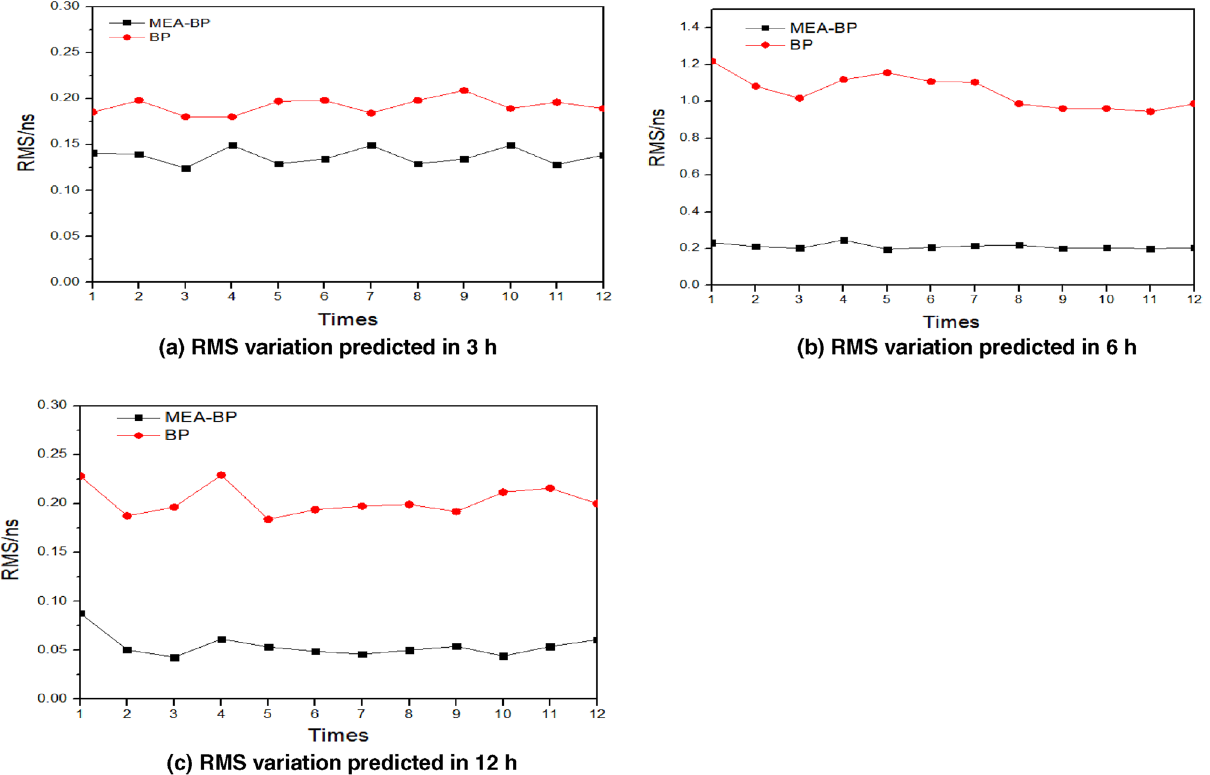
Figure 4. Variation in RMS using MEA-BP and BP to predict for 10